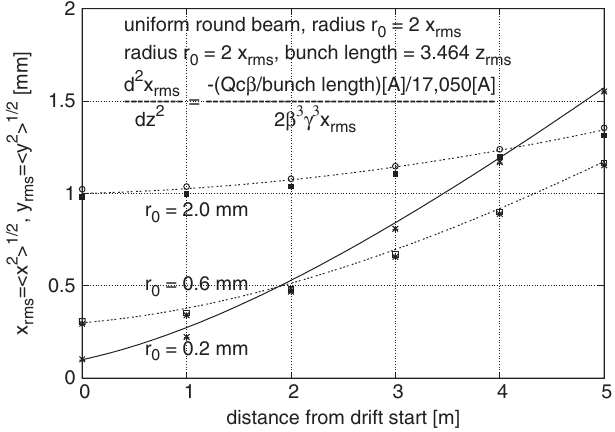
FIG. 18. Evolution of a Q ¼ 77 pC , 10 MeV electron bunch through a drift region. Though the bunch is uniformly distributed in all three dimensions (beer can shape), its transverse dimen- sions are expressed as rms values of x and y , which almost superimpose since the beam is round. The rms bunch length is 0.9 mm. With all particles initially parallel to the axis, the smooth curves are solutions of the ‘‘envelope equation’’